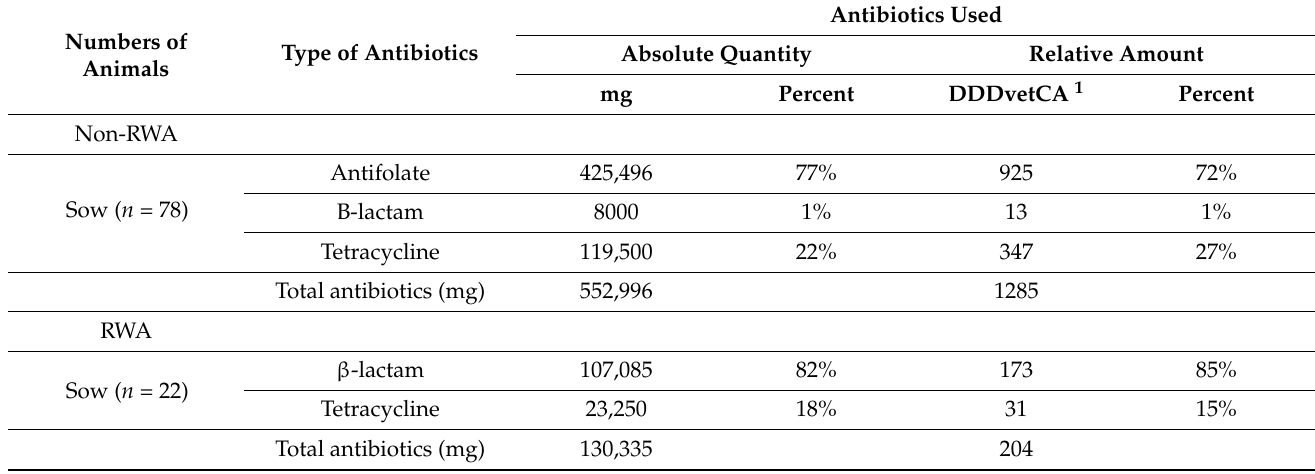
Table 1. Quantification of antibiotics administered to sows in the participating